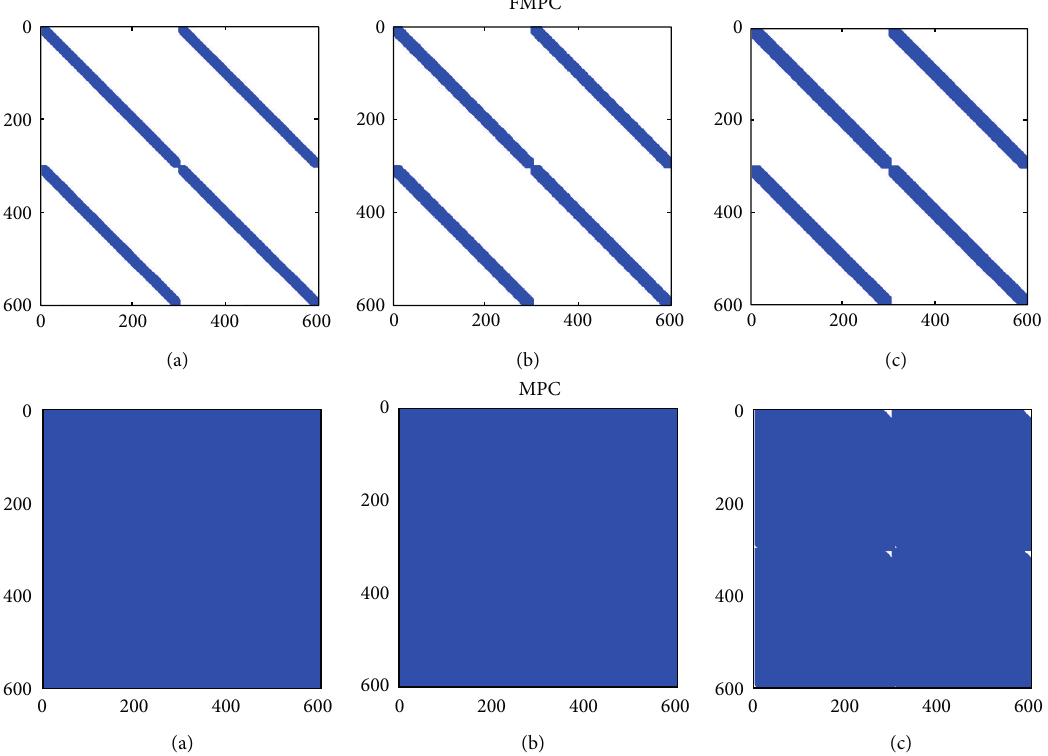
Figure 8: Effect of prediction horizon on the structure of the state matrix: FMPC (a) Case 1 ( 𝑁 = 10 , 𝑛𝑧 = 28800 ), (b) Case 2 ( 𝑁 = 20 , 𝑛𝑧 = 35100 ), and (c) Case 3 ( 𝑁 = 30 , 𝑛𝑧 = 40210 ); MPC (a) Case 1 ( 𝑁 = 10 , 𝑛𝑧 = 359880 ), (b) Case 2 ( 𝑁 = 20 , 𝑛𝑧 = 360000 ), and (c) Case 3 ( 𝑁 = 30 , 𝑛𝑧 = 357655 ).